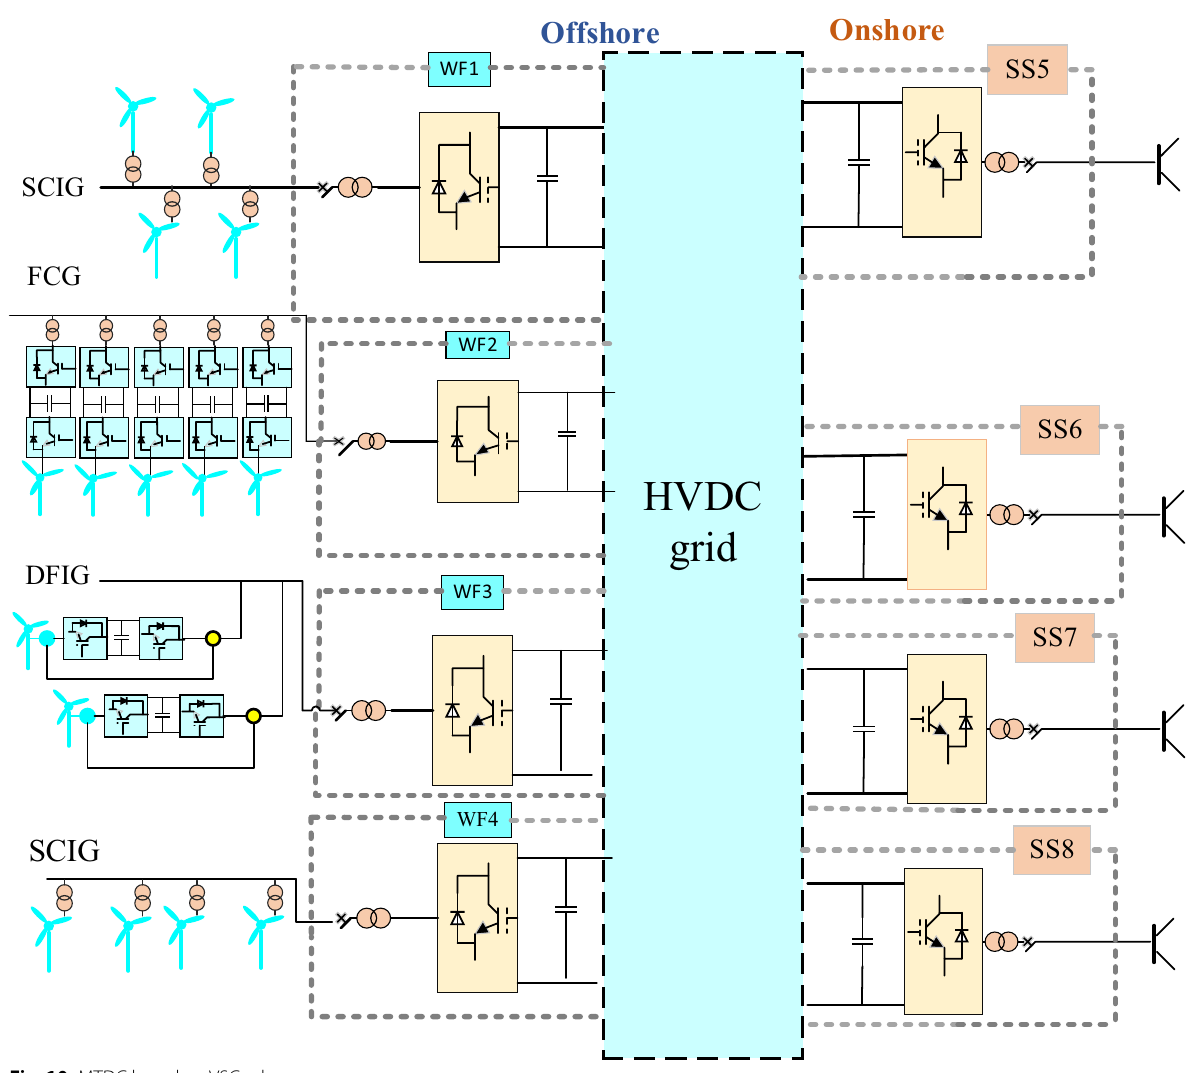
Fig. 10 MTDC based on VSC